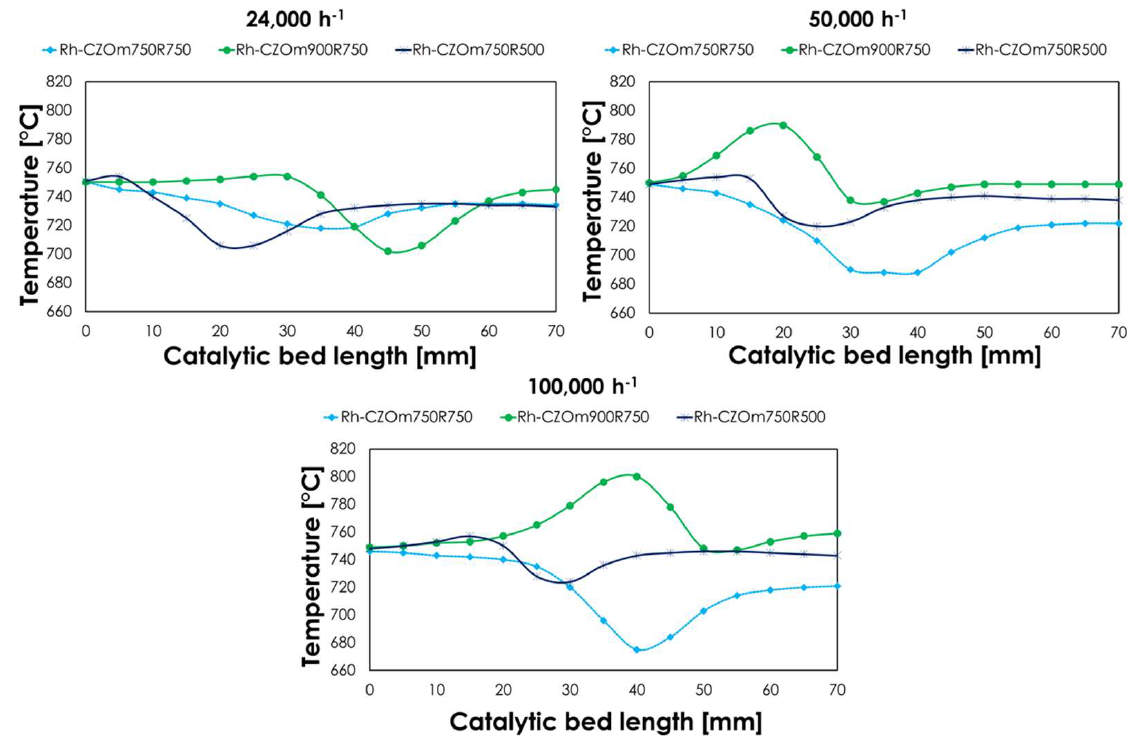
Figure 12. Temperature profile of the catalytic bed of the investigated catalysts at T oven = 750 °C, 1 atm, S/C = 0.7, O2/C = 0.2 and 24,000 h −1 (left), 50,000 h −1 (center) or 100,000 h −1 (right) obtained with a sliding thermocouple.